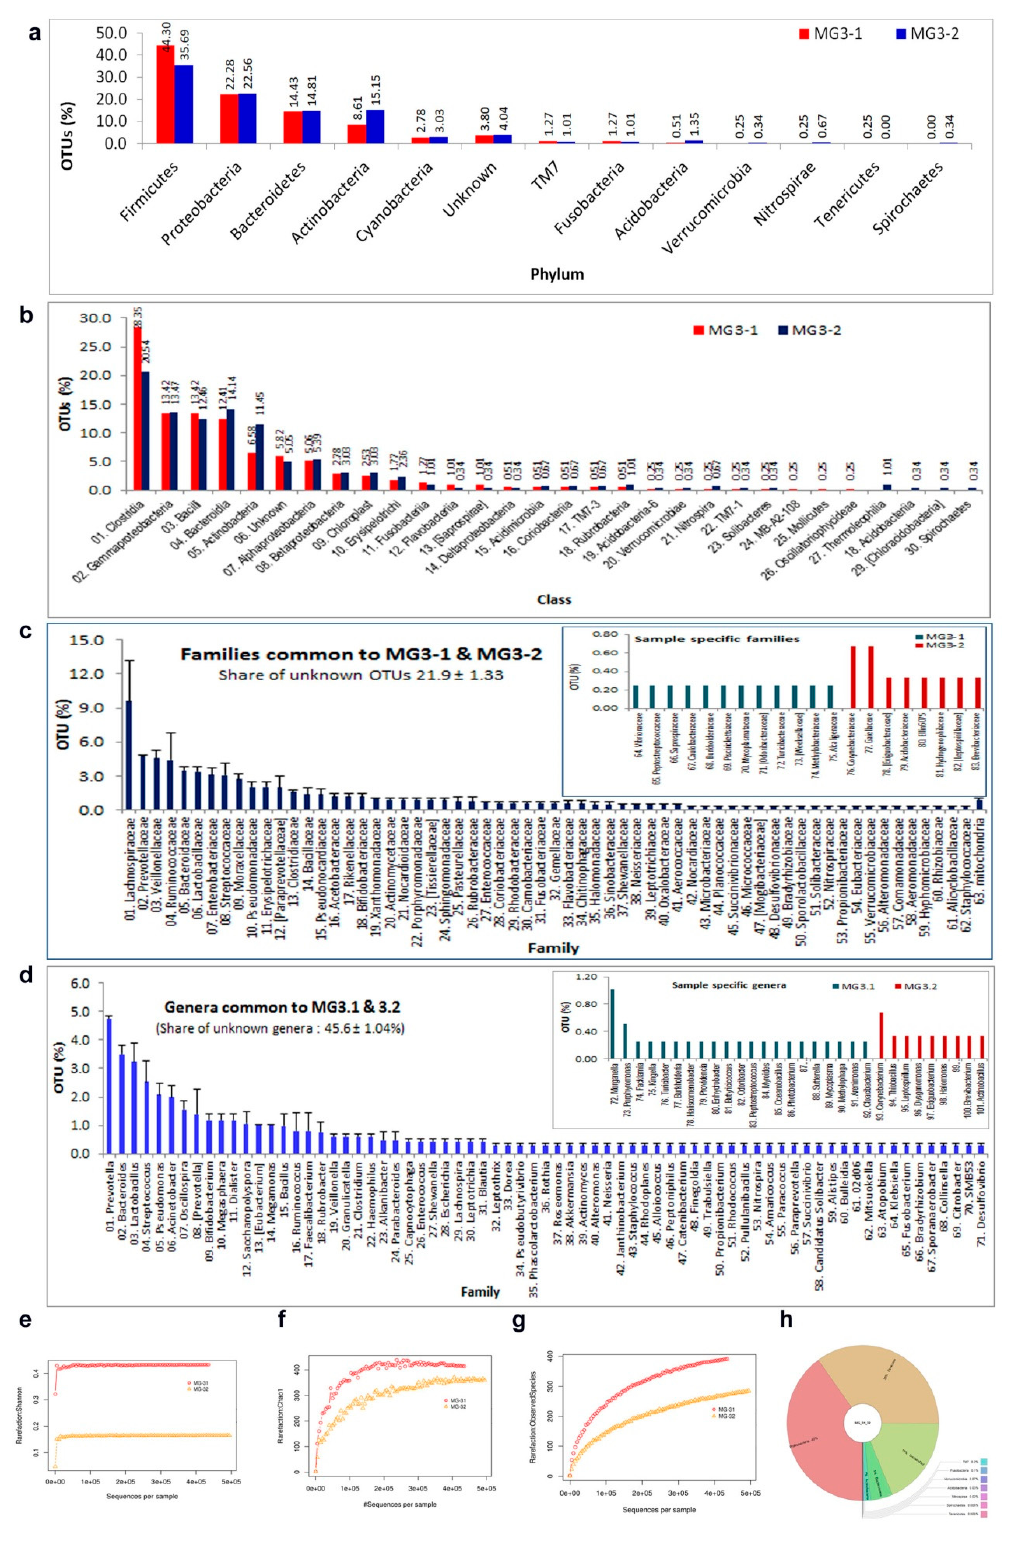
Figure 7. Images of 16S rRNA metagene V3 region profiling with Illumina MiSeq NGS platform on grape cell culture “FU01”-derived DNA samples MG3-1 and MG3-2 adopting 2 × 150 bp sequencing chemistry showing the distribution of OTUs after QIIME analysis-I and diversity metrics. ( a ) OTU distribution at the phylum level, ( b ) OTU distribution at the class level, ( c ), OTU distribution at the family level, and ( d ) OTU distribution at the genus level; ( e ), Shannon diversity analysis, ( f ) Chao1 diversity analysis, ( g ) observed species metrics, and ( h ) circular graphical representation of reads through Krona.